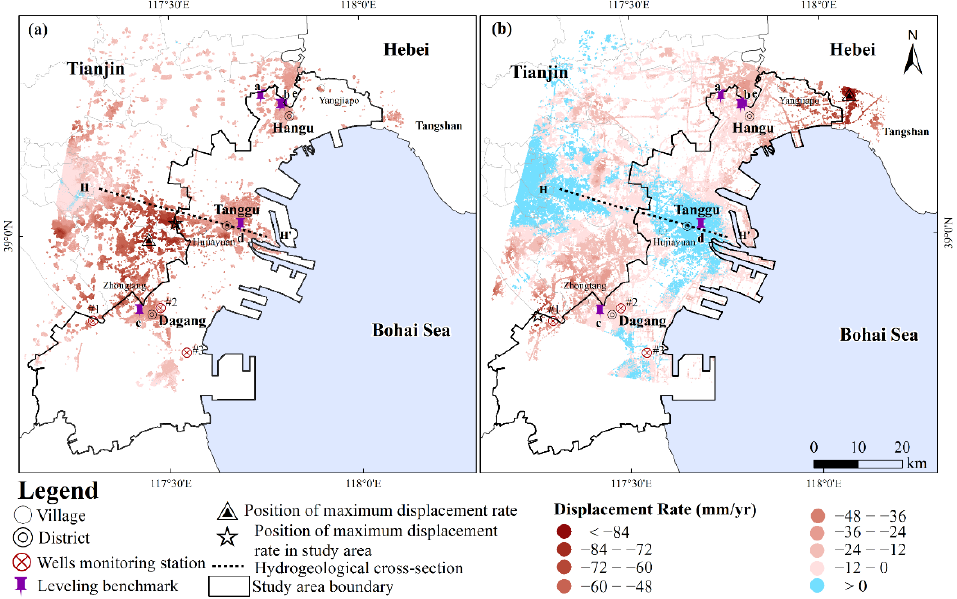
Figure 6. Average vertical displacement rates obtained by the InSAR techniques in the Binhai New Area: ( a ) SBAS from 2003 to 2010 and ( b ) PSI from 2015 to 2020. Negative values indicate subsidence, and positive values indicate uplift.